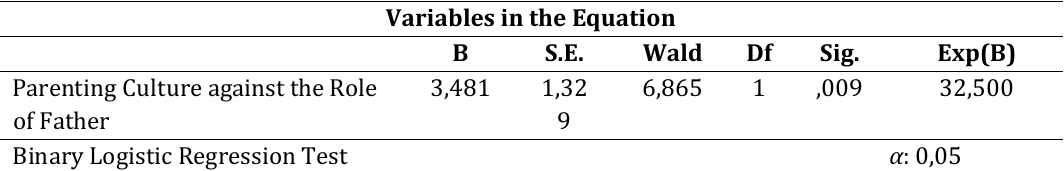
Variables in the Equation